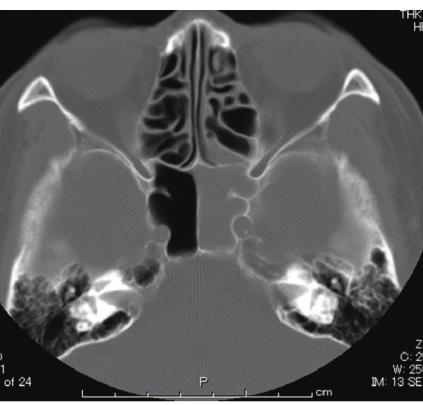
Figure 1: CT findings. The left sphenoid sinus shows a soft tissue shadow without bone damage.